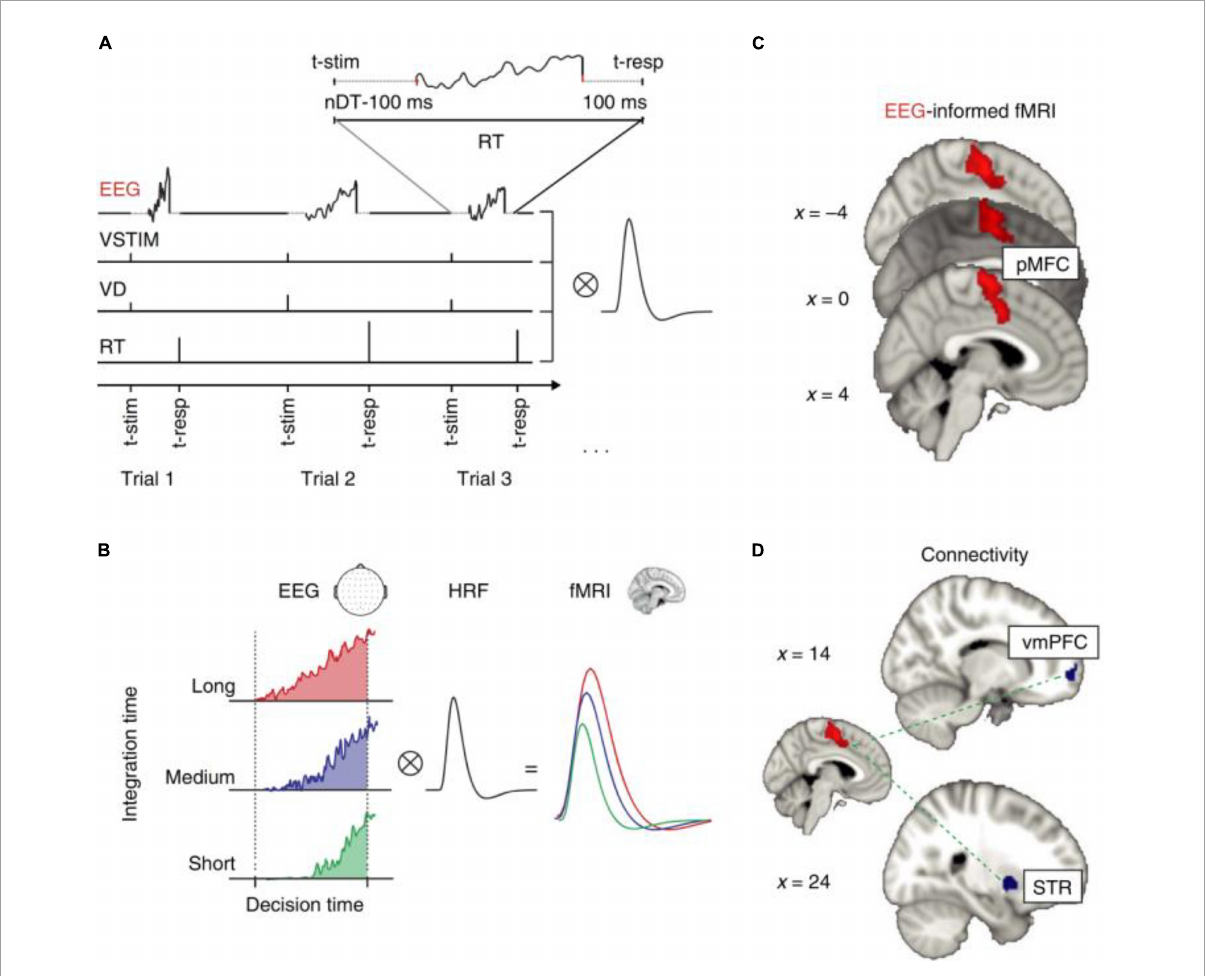
FIGURE9 “EEG-informed fMRI and connectivity analyses in the value-based task. (A) The fMRI GLM model included an EEG-informed regressor capturing the electrophysiological trial-by-trial dynamics of the process of evidence accumulation (EA) in each participant. Three actual single-trial EEG traces are shown. The traces cover the entire trial excluding the time intervals accounting for stimulus processing and motor execution (see inset and Methods for details). To absorb the variance associated with other task-related processes we included three additional regressors: VSTIM—an unmodulated stick function regressor at the onset of the stimuli, VD—a stick function regressor at the onset of stimuli that was parametrically modulated by the value difference between the decision alternatives and RT—a stick function regressor aligned at the time of response and modulated by RT. (B) Hypothetical EA traces in response-locked EEG activity ramping up with different accumulation rates. Convolving these traces with a hemodynamic response function (HRF) leads to higher predicted fMRI activity for longer compared to shorter integration times (that is, the predicted fMRI response scales with the area under each EA trace). (C) The EEG-informed fMRI predictor of the process of EA revealed an activation in pMFC. (D) PPI analysis using the pMFC cluster identified in c as a seed revealed an inverse coupling with a region of the vmPFC and the STR. All activations represent mixed-effects and are rendered on the standard MNI brain at |Z| 42.57, cluster-corrected using a resampling procedure (minimum cluster size, 76 voxels)” (Pisauro et al.,